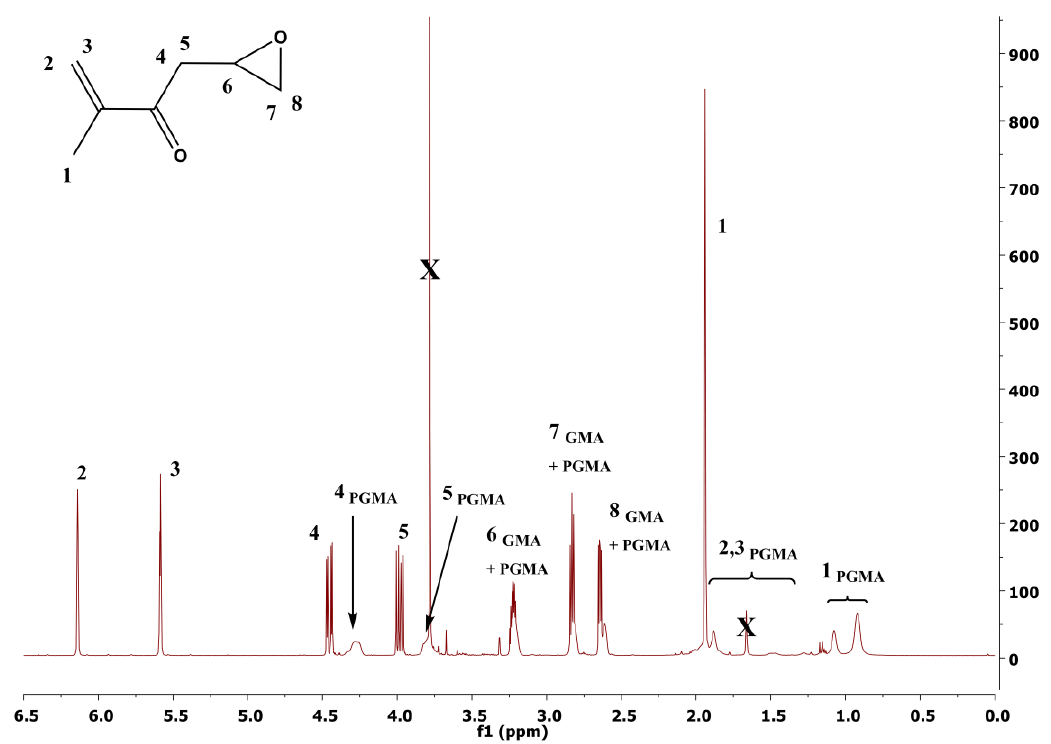
Figure 1. Representative 1 H NMR spectrum from filtered polymerization mixture of glycidyl methacrylate performed with [GMA]:[EBiB]:[CuBr]:[PMDETA] ratio of [100]:[1]:[1]:[4] at 60 °C for 4 h. The monomer conversion was